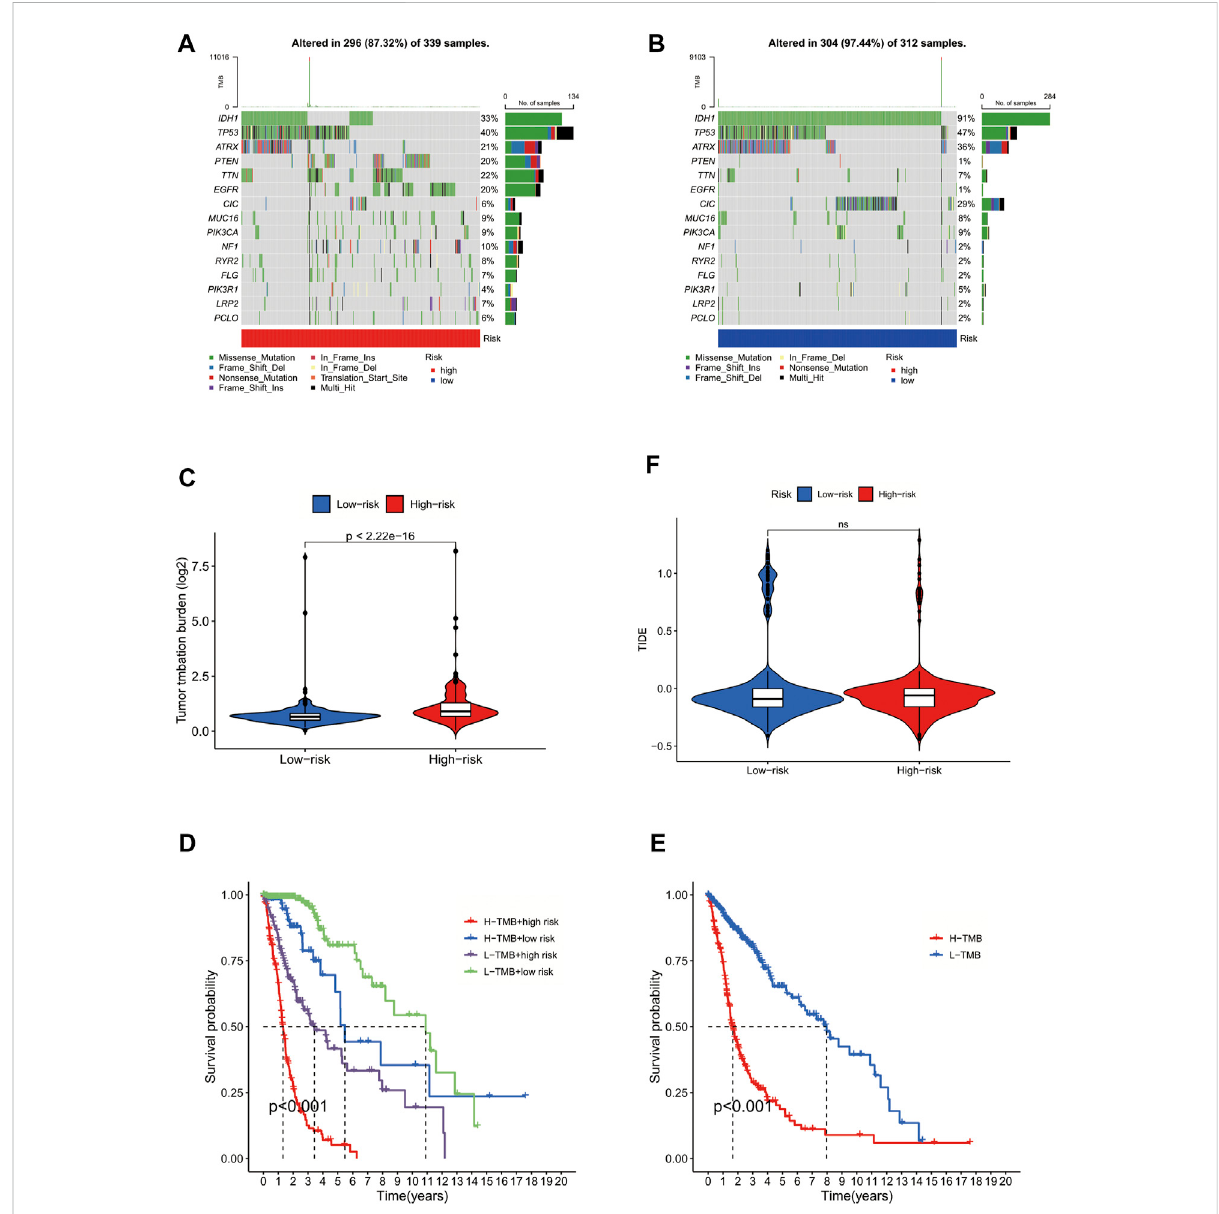
FIGURE 5 GLSinvolvedintumourmutationingliomacells. (A) Forestplotofhigh-riskgroup. (B) Forestplotoflow-risk group. (C) Violin plotofdifferential analysis of tumour mutation burden. (D) Survivalcurve ofpatients inhigh andlow mutationload groups. (E) Survivalcurveof patients inhigh andlow mutation load and high- and low-risk groups. (F) Violin plot of immune escape.